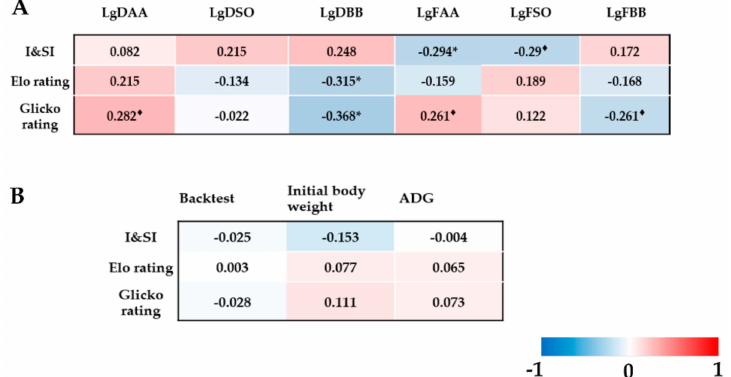
Figure 3. ( A ) Partial correlation analyses between hierarchical indices (I&SI, Elo rating, or Glicko rating) and logarithms of dyadic behavioral indicators. ( B ) Partial correlation analyses between hierarchical indices (I&SI, Elo rating, or Glicko ratings) and backtest score, initial body weight or average daily gain (ADG). “*” represents p < 0.05. “ (cid:7) ” represents 0.05 < p < 0.1. Blue color represents negative correlation and red color represents positive correlation. Cells were colored on a gradient from blue (r = − 1) to red (r = 1), where the colors were related to the correlation coe ffi cients. DAA = Duration of active attack; DSO = Duration of stando ff ; DBB = Duration of being bullied; FAA = Frequency of active attack; FSO = Frequency of stando ff ; FBB = Frequency of being